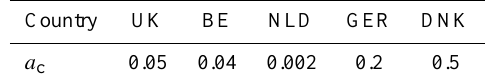
Table 3. Failure probability model. Efficiency coefficient. Country